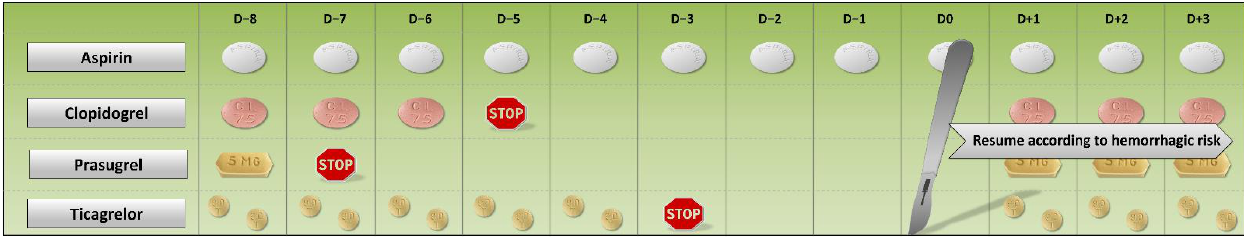
Figure 3. Our institutional schema for management of antiplatelet medications in planned cardiac surgery.